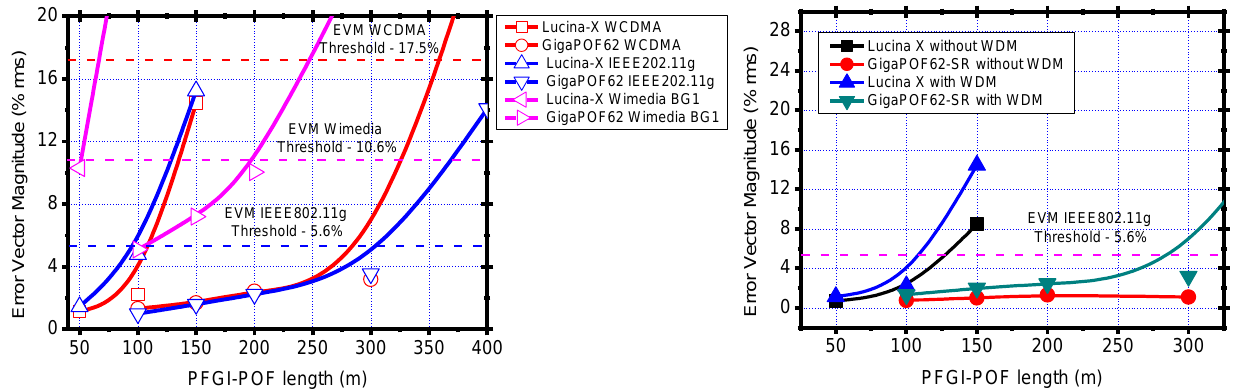
Figure 22. ( Left ) Evolution of the EVM as a function of the PFGI-POF length (WCDMA, IEEE802.11g and Wimedia BG1). The measurements have been performed with the system including the WDM devices. ( Right ) Illustration of the EVM penalties owing to the WDM devices for the IEEE802.11g WLAN